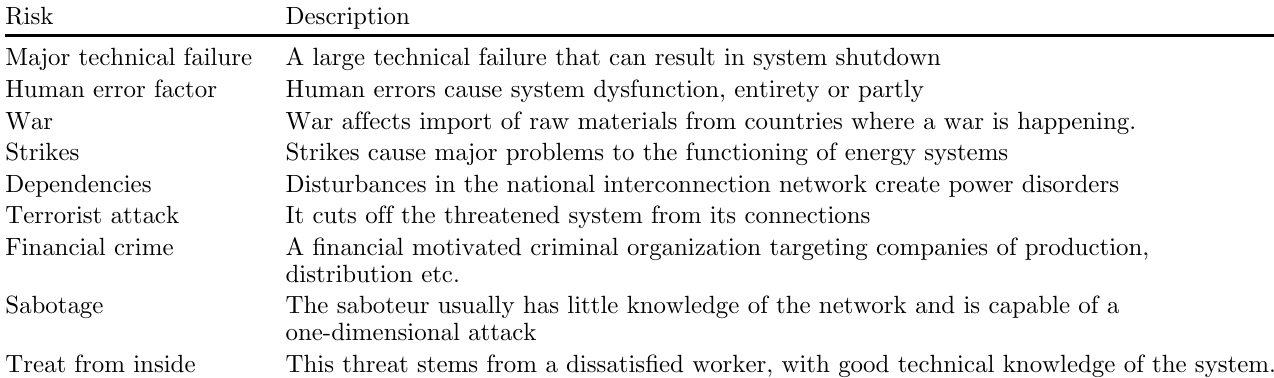
Table 2. Anthropogenic and technological risk ’ s scenarios for RES [55].